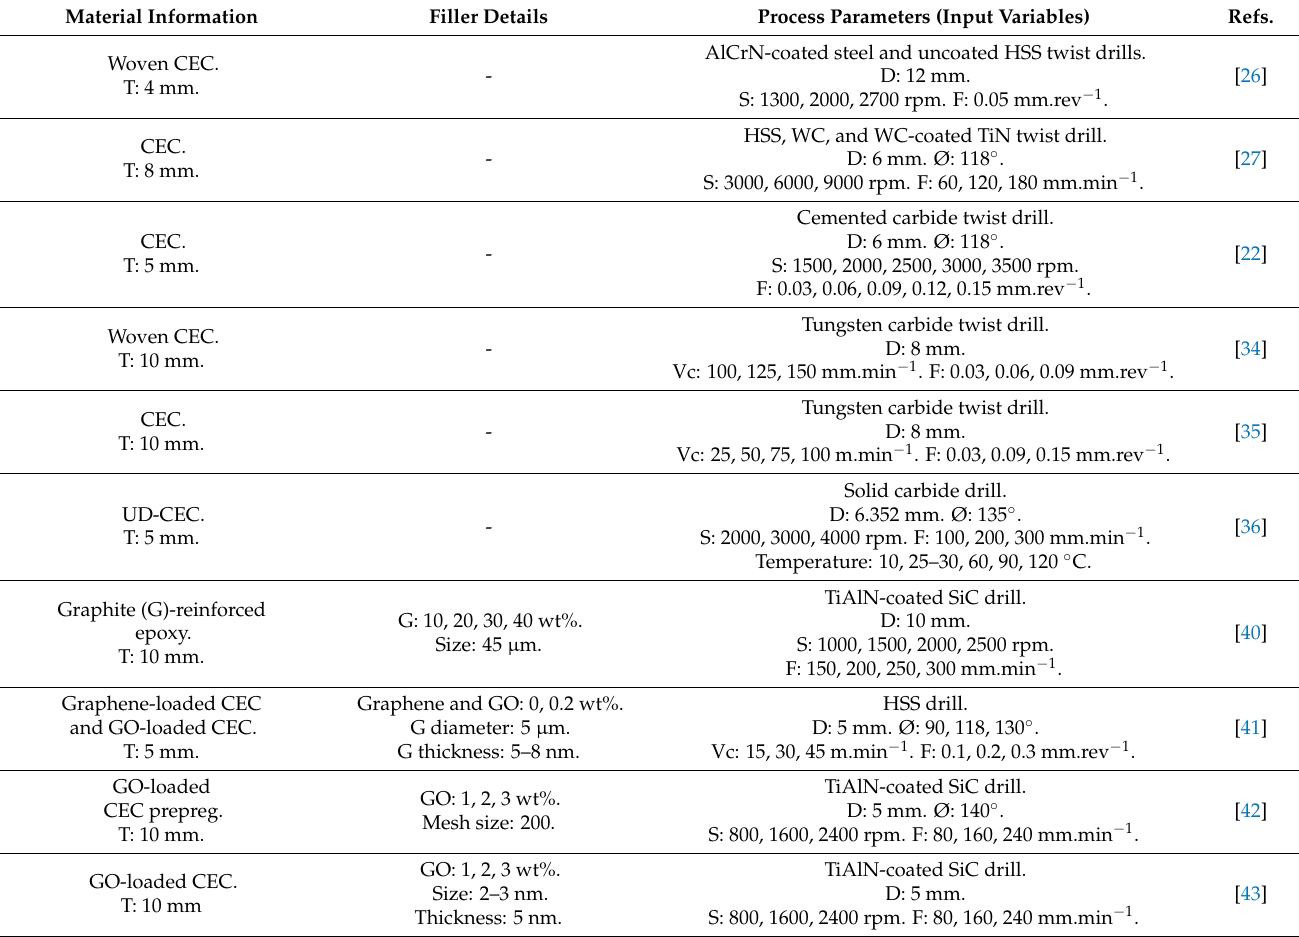
Table 1. Process parameters considered for drilling CEC and filler-loaded CEC in the literature. Material Information Filler